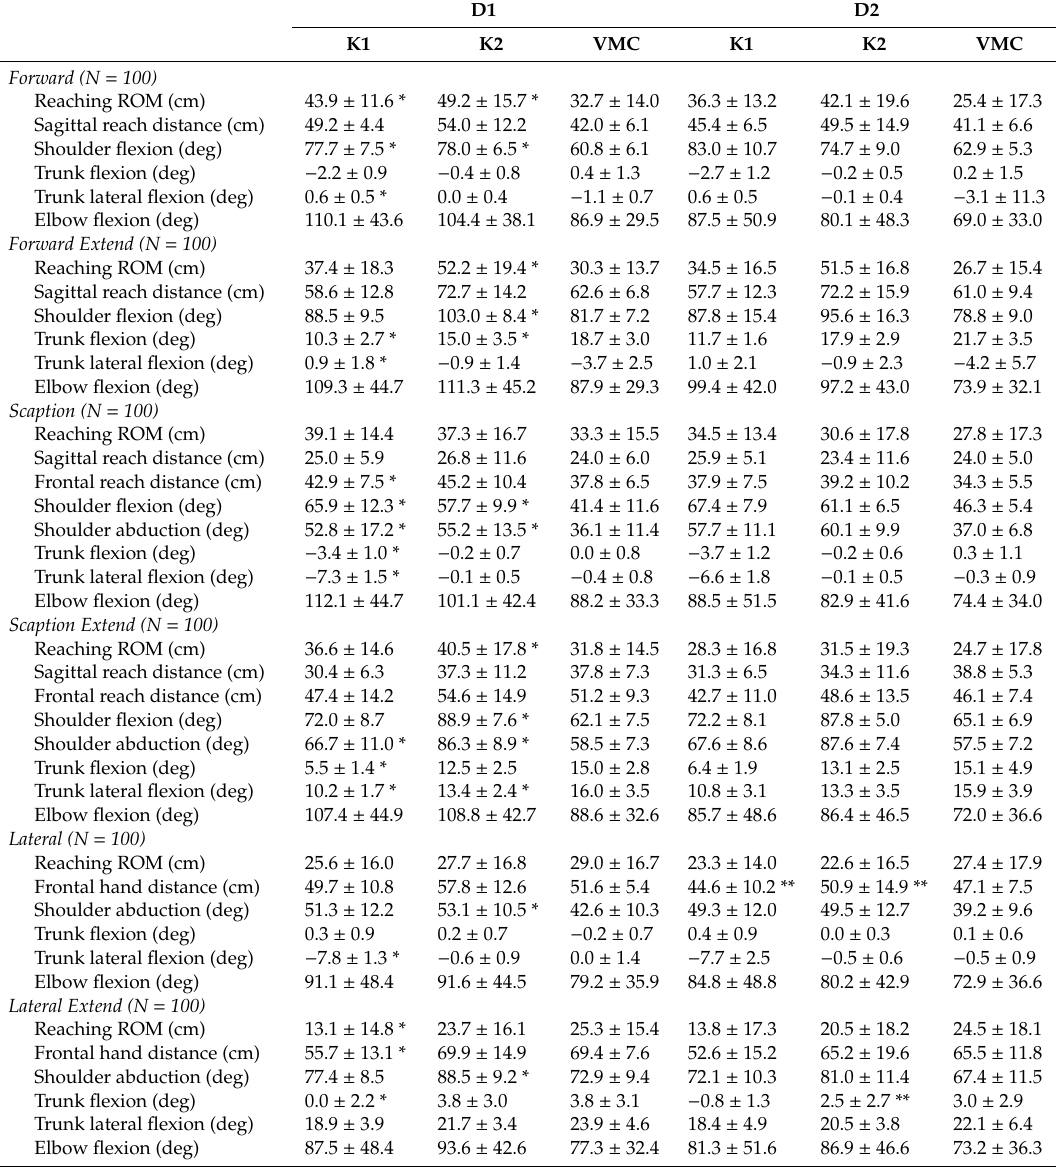
Table 1. Mean ( ± SD) magnitudes for the K1, K2, and VMC for all kinematic variables and all movements on the two di ff erent testing days D1 and D2. Each of five participants performed four sets of five reaches (N = 100) for each direction and condition. This sample was repeated on two separate testing days (D1 and